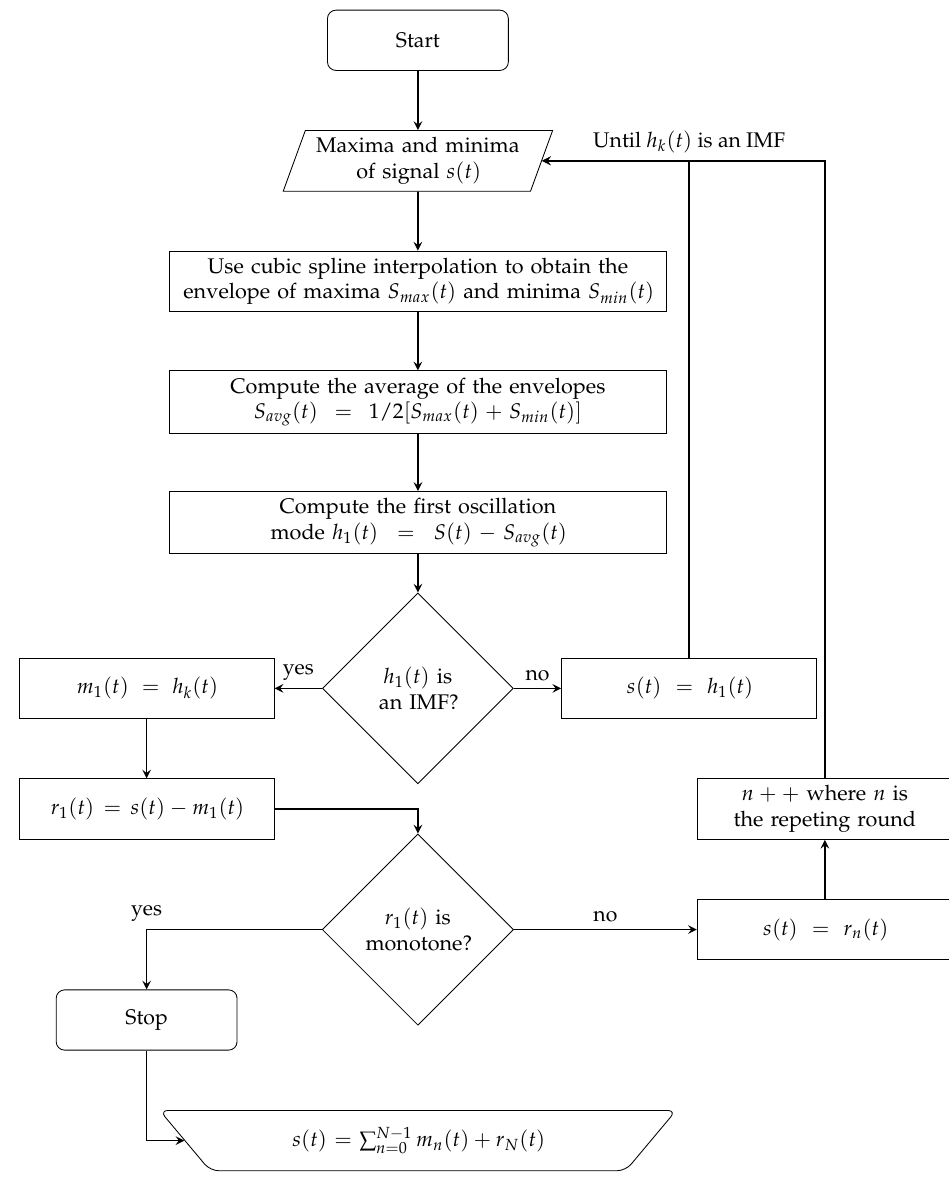
Figure 7. Flowchart of Empirical Mode Decomposition (EMD)